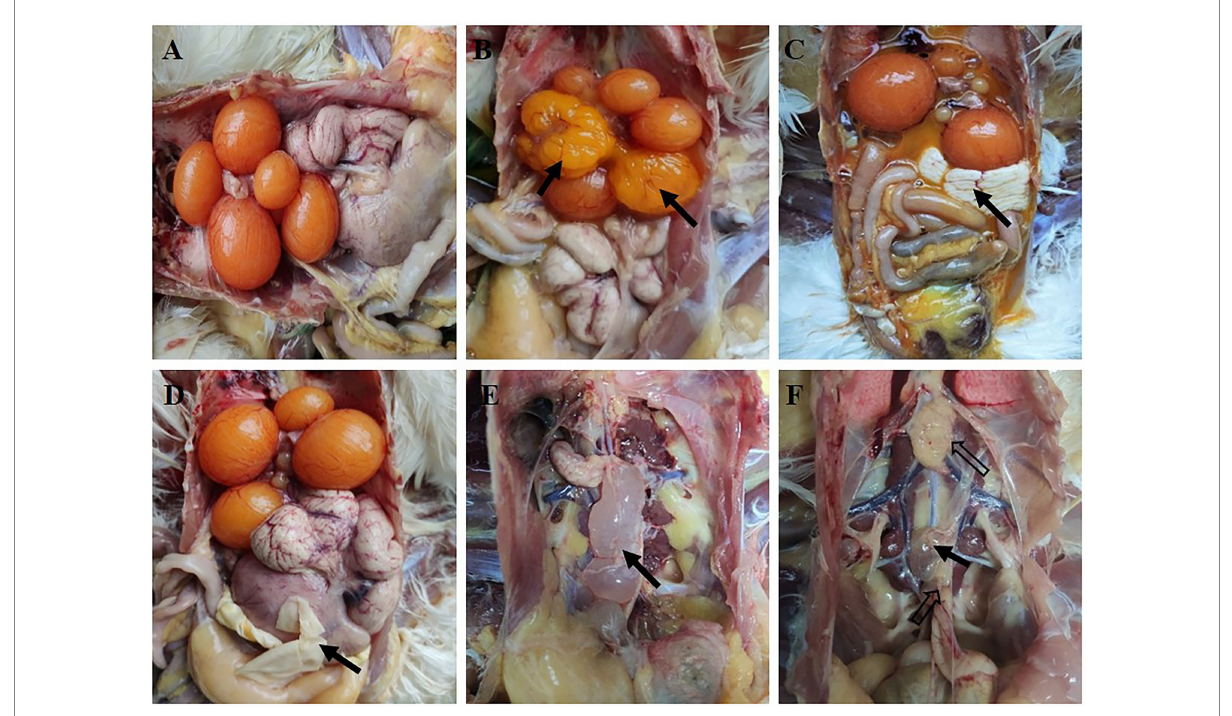
FIGURE 6 Gross lesions were observed in the ovary and oviduct of the hens at 170 dpi. (A) Well-developed organs from the control group. (B) Flaccid ovary. (C,D) The fluid yolk material and fibrin clots in the coelome. (E) Cystic dilation in the oviduct. (F) Oviduct and ovary with retarded